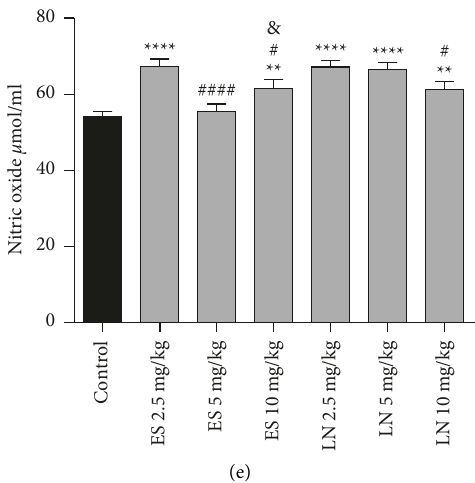
Figure 4: Effect of esomeprazole (ES) and lansoprazole (LN) treatment on oxidative stress biomarkers in rat testis. ∗ , ∗∗ , ∗∗∗ , and ∗∗∗∗ showed significant results at P < 0 . 05 , 0 . 01 , 0 . 001, and 0.0001 on contrary to control group. # , ## , and #### showed significant results at P < 0 . 05 , 0 . 01, and 0.0001 on contrary to esomeprazole/lansoprazole 2.5mg/kg/day. & , && , and &&&& showed significant results at P < 0 . 05 , 0 . 01, and 0.0001 in contrary to esomeprazole/lansoprazole